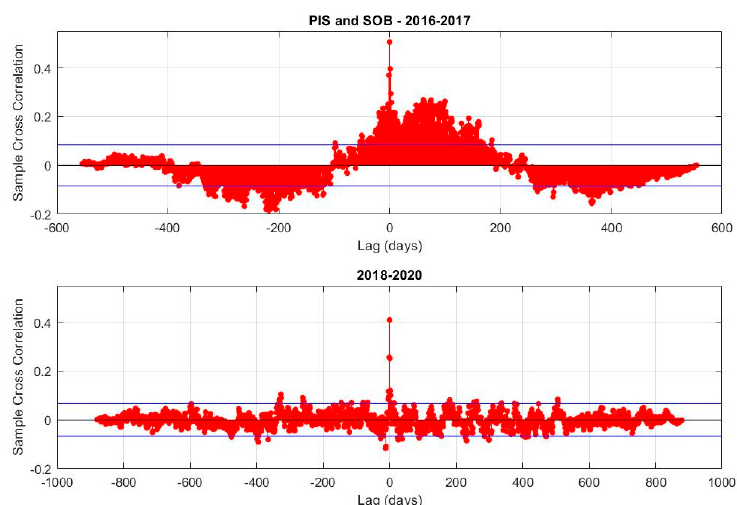
Figure 6. Correlation analysis between PIS and SOB for the time-range 2016–2017 ( top ) and 2018–2020 ( bottom ). The blue lines mark the confidence limits (95%), above which the correlation among the time-series is considered significant.